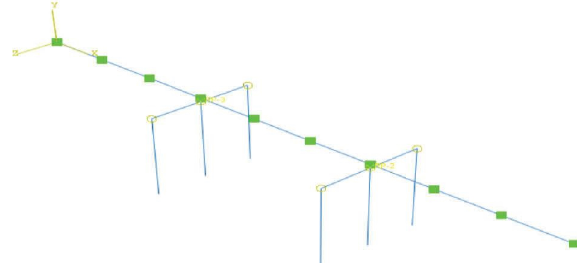
Figure 6: Structural model of double aqueduct.